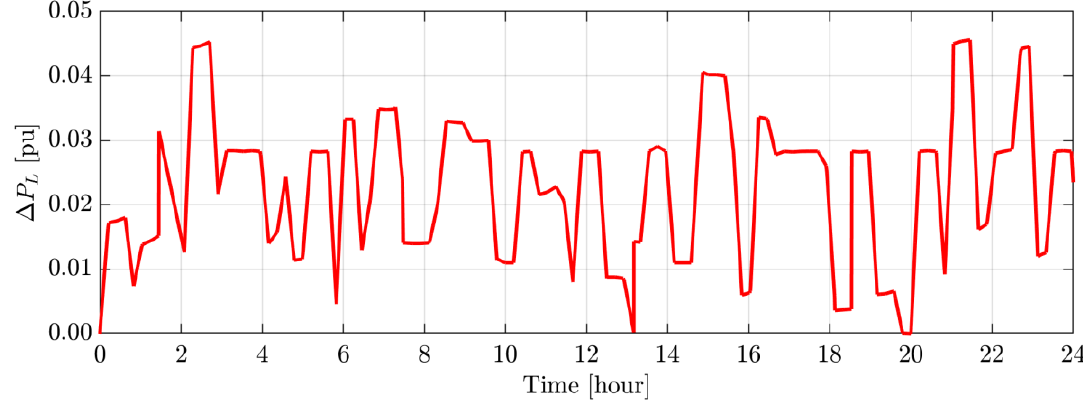
Figure 20. Random load change for the long-term study for the scenario C.